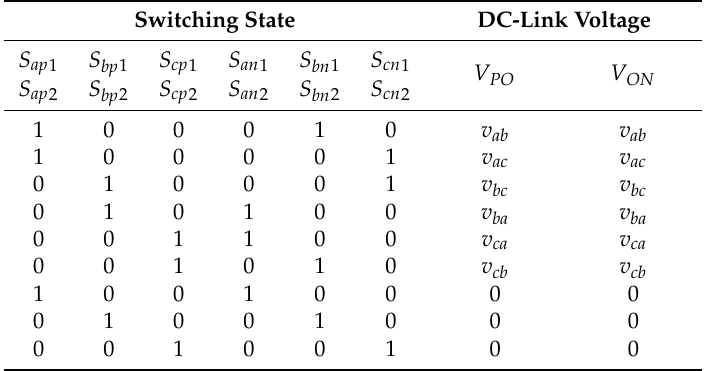
Table 1. The switching states at rectifier stage and the DC-link voltage. Switching State